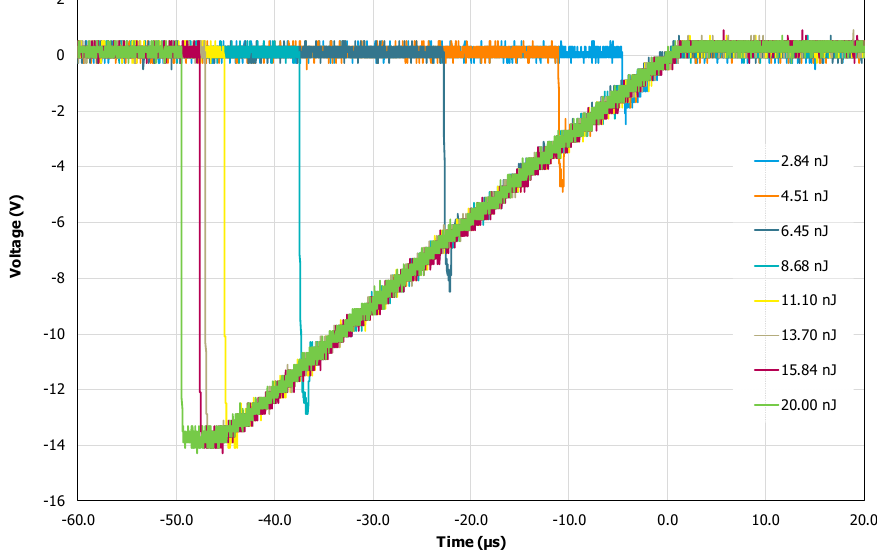
Figure 6. The response of the Q9 region to 1064 nm photons at different incident pulse energies. As can be seen from Figure 6, the first transient voltage was observed when the pulse laser energy gradually increased to 2.84 nJ, and it was negative. Then, with the increasing pulse laser energy, the amplitude of the transient voltage also increased, and the maximum value of the transient voltage occurred when the laser energy was 20 nJ.